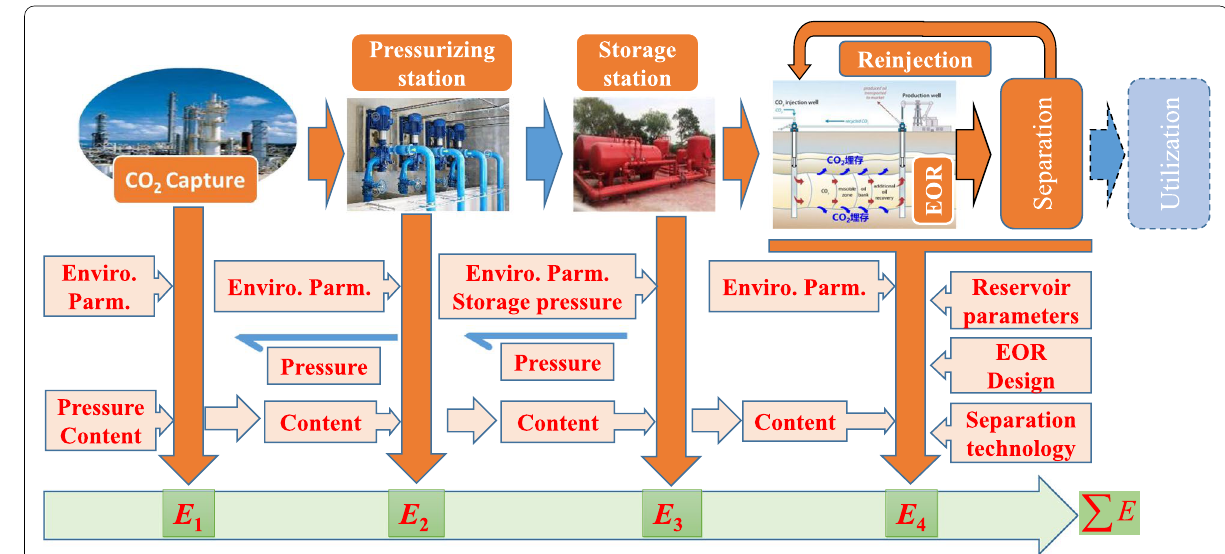
Fig. 1 Schematic diagram of the full‑chain CCUS‑EOR